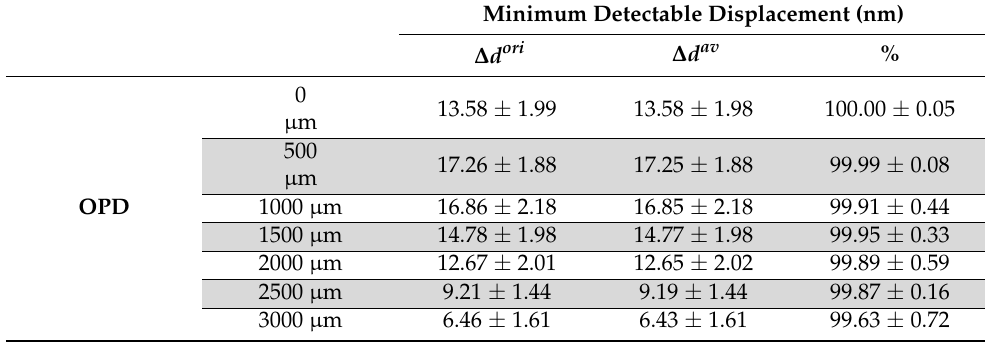
Table 2. Minimum detectable displacements at different optical path differences (OPDs) computed using the original ( ∆ d ori ) and proposed ( ∆ d av ) estimators. Data are presented as the mean ± standard deviation of 256 lateral locations at each OPD.